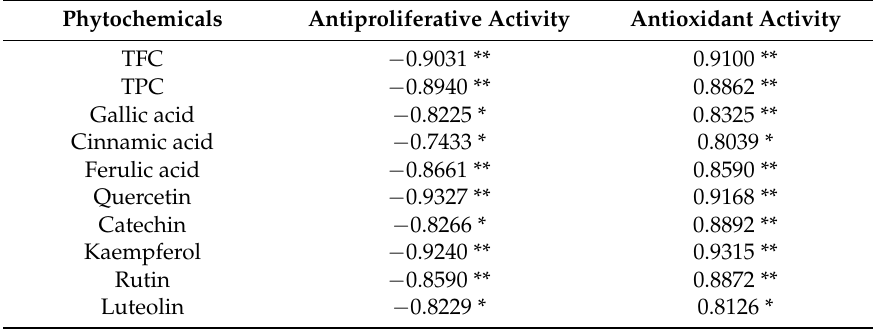
Table 3. Correlations (R 2 ) among human breast cancer cell proliferation, antioxidant activity and identified phytochemicals from sweet basil